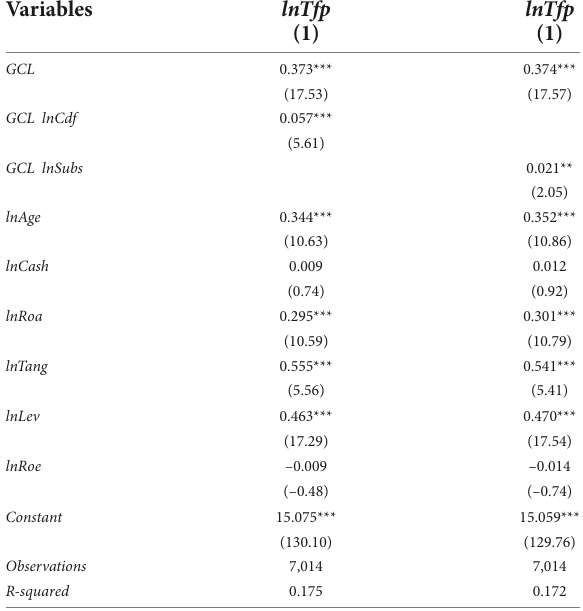
TABLE 8 Tests for moderating